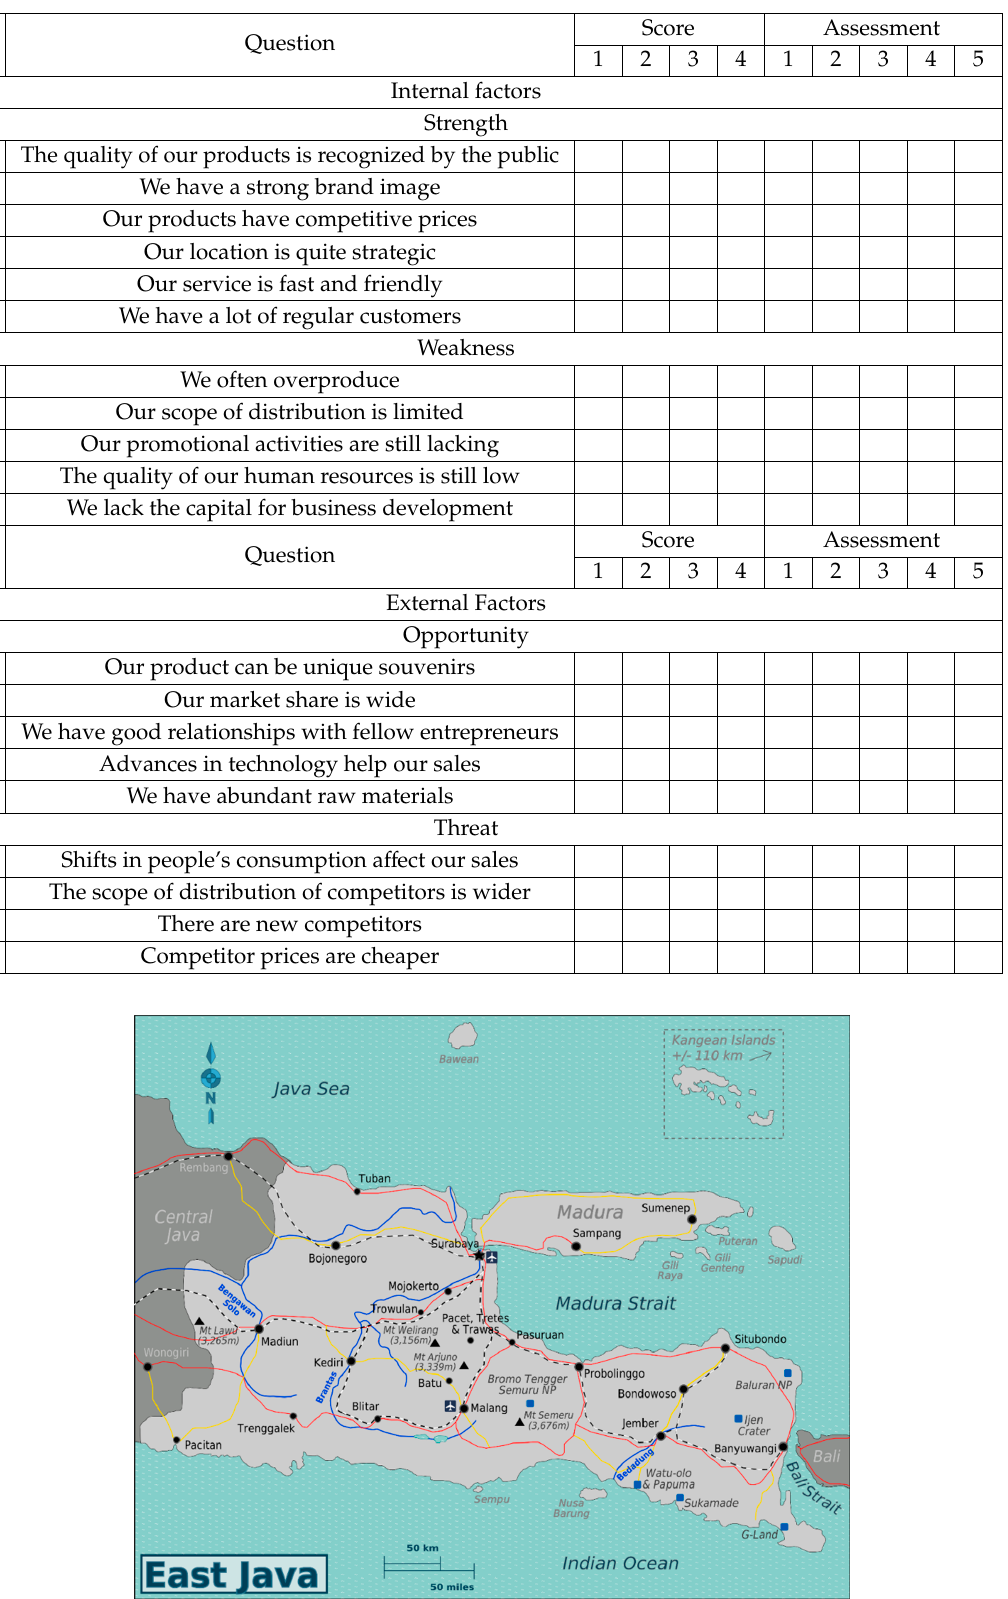
Figure A12. East Java.